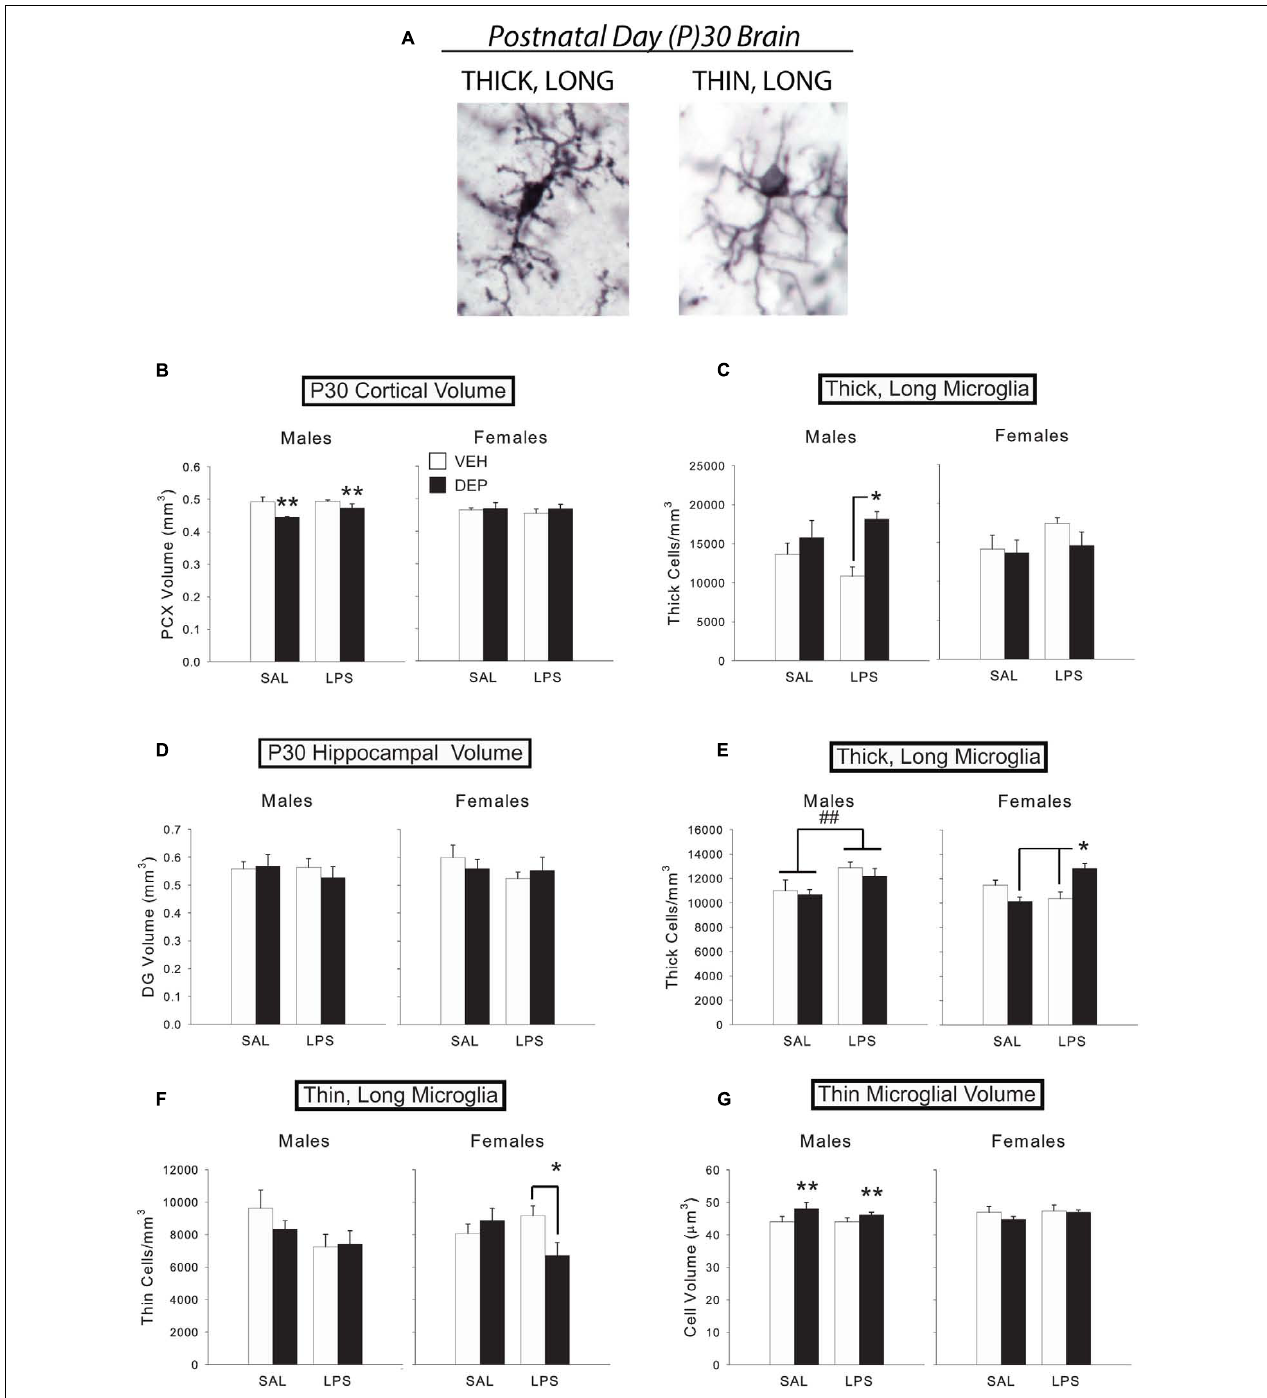
FIGURE 2 | Prenatal DEP exposure alters microglial morphology and cortical volume in the P30 juvenile brain. (A) The two primary microglial morphological states in the P30 brain. Representative pictures of microglia with thick, long processes (left) and thin, long processes (right) in the mouse parietal cortex on P30. Photos were taken of Iba1-labeled microglia at 100X. (B) DEP males possess a significantly smaller PCX volume at P30 than VEH males, whereas females do not differ. (C) DEP/LPS males have significantly more thick, long microglia in the PCX at P30 than do VEH/LPS males, whereas females do not differ. (D) No significant differences in DG volume were detected. (E) LPS males had significantly more thick, long microglia in the DG at P30 than SAL males. DEP/LPS females had significantly more thick, long microglia than VEH/LPS and DEP/SAL females. (F) LPS males tended to have fewer thin, long microglia than SAL males in the P30 DG, whereas DEP/LPS females had significantly fewer thin, long microglia than VEH/LPS and DEP/SAL females. (G) DEP males have thin, long microglia with larger soma volumes in the DG at P30 than do VEH males, whereas females do not differ. Data are mean ± SEM, n = 5–7/group/sex. ∗∗ p = 0.05, DEP vs. VEH; ∗ p < 0.05 vs. VEH/LPS or DEP/SAL; ## p < 0.05, LPS vs. SAL.